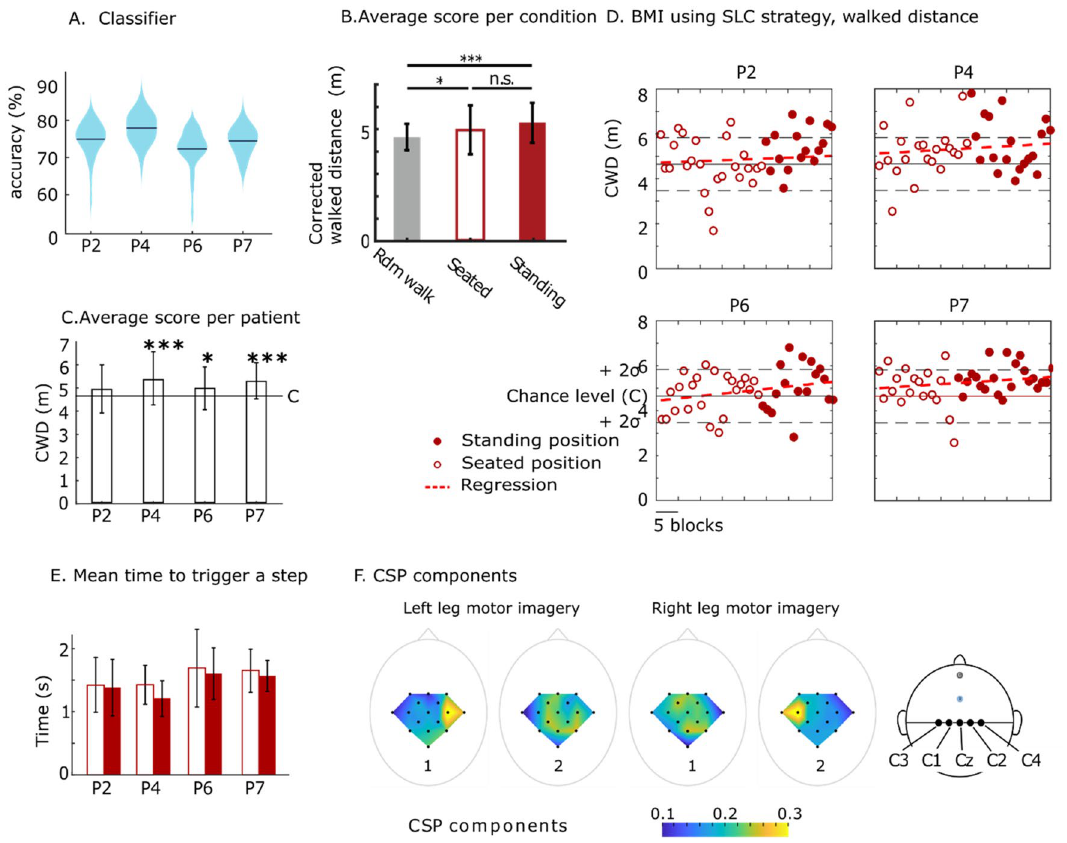
Figure 2. BMI scores. ( A ) EEG classifier accuracy for the calibration sessions. ( B ) The mean corrected walk distance (CWD) for BMI sessions performed when the subject was seated (empty red bar) or standing position (red filled bar). Both conditions are compared to random (see Supplementary Fig. S1 for description). * P < 0.05, ** P < 0.01. Bars are stand deviation (SD) ( C ) Mean and SD for the CWD for the four study participants